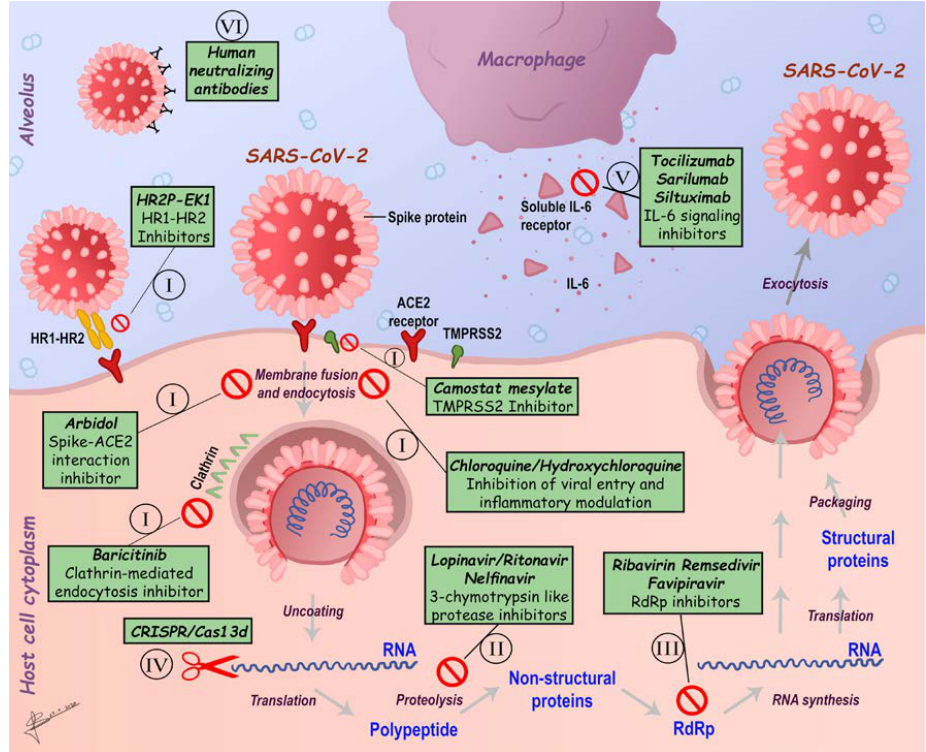
Figure 8. Schematic representation of SARS-CoV-2 infection and virus-induced human immune system response. Proposed drugs directed both towards specific SARS-CoV-2 molecular targets and biologic processes are highlighted: inhibitors of SARS-CoV-2 fusion/entry targeting ACE2 receptor, spike protein, TMPRSS2 or HR1 and HR2 epitopes and clathrin-mediated endocytosis (I); molecules against SARS-CoV-2 main protease (II); molecules against viral genome replication (III); CRISPR technologies targeting SARS-CoV-2 RNA genome (IV); modulators of SARS-CoV-2 induced inflammatory response (V) and human neutralizing antibodies (VI). ACE2, angiotensin-converting enzyme 2; TMPRSS2, type 2 transmembrane serine proteases; RdRp, RNA-dependent RNA polymerase; HR1, heptad repeat 1; HR2, heptad repeat 2; HR2P, heptad repeat 2-derived peptides; EK1, a modified OC43-HR2P peptide. Adapted from